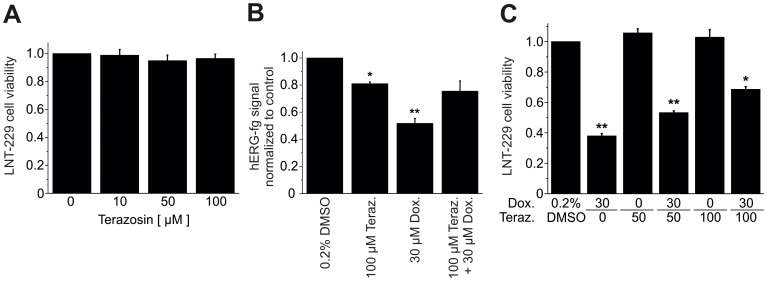
The small molecule hERG inhibitor terazosin protects GB cells from doxazosin-induced apoptosis.(A, B) Terazosin treatment did not impair LNT-229 cell viability (A) and caused less suppression of hERG protein compared to doxazosin (B). Combined drug exposure attenuated doxazosin-associated hERG protein suppression (B). Cell death quantified using the XTT assay was inhibited in concentration-dependent fashion (C). Mean (± SEM) data are presented (n = 4 to 6 assays; *p<0.05; **p<0.01).